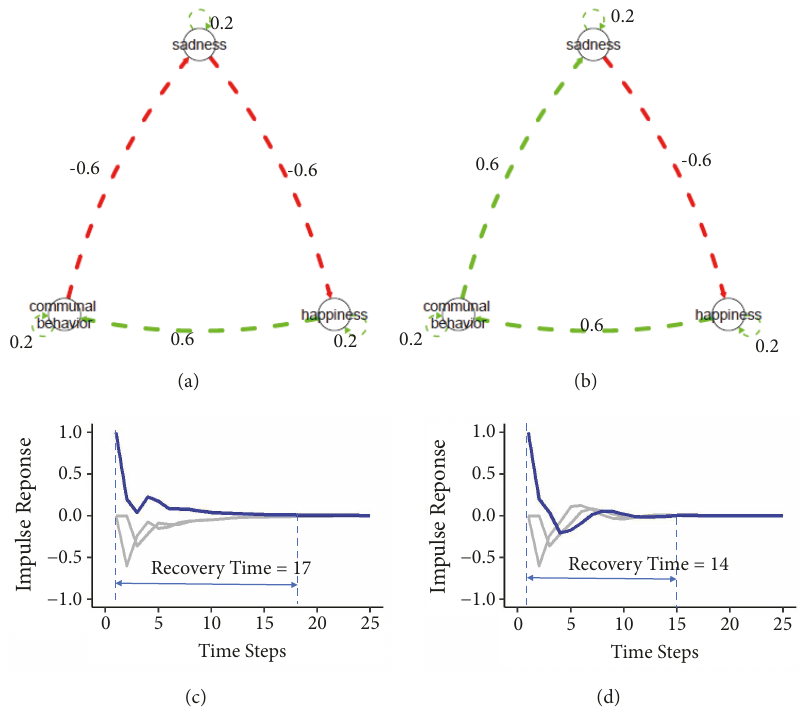
Figure 1: Conceptual example to illustrate effect of socioemotional dynamics on emotion regulation. (a) and (b) are two different networks, and edges (arrows) indicate significant temporal associations between nodes (circles). Red edges are negative associations, green edges are positive associations. Dashed edges are lagged effects. Edge width indicates strength of the temporal relation, whose weight is marked close to the edges. Both networks have density of 2.4. (c) and (d) are corresponding time profiles for the networks in (a) and (b), respectively.